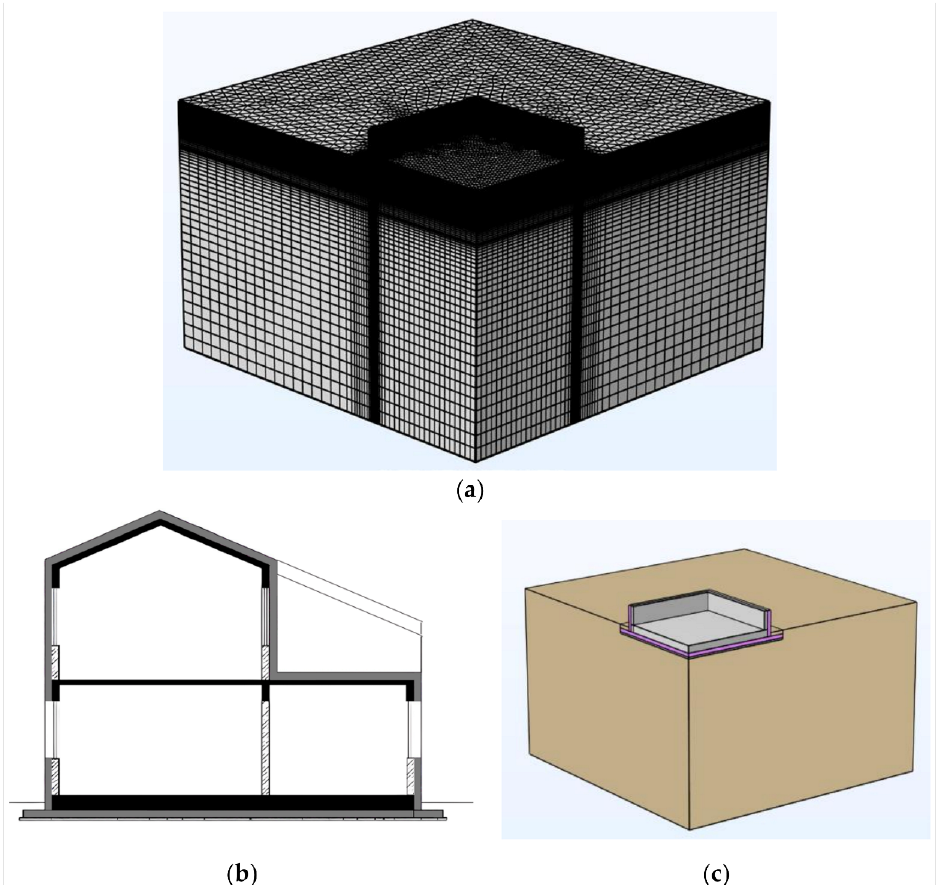
Figure 4. ( a ) Model gridding. ( b ) Building section diagram. ( c ) Simulation